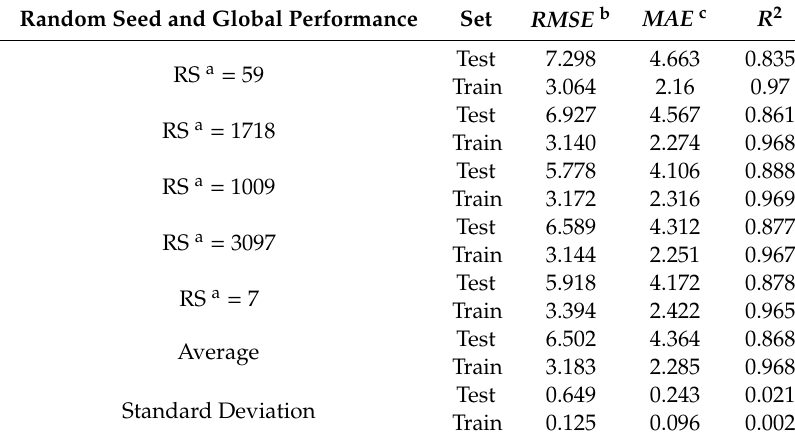
Table 12. Measured performance of deep learning model.